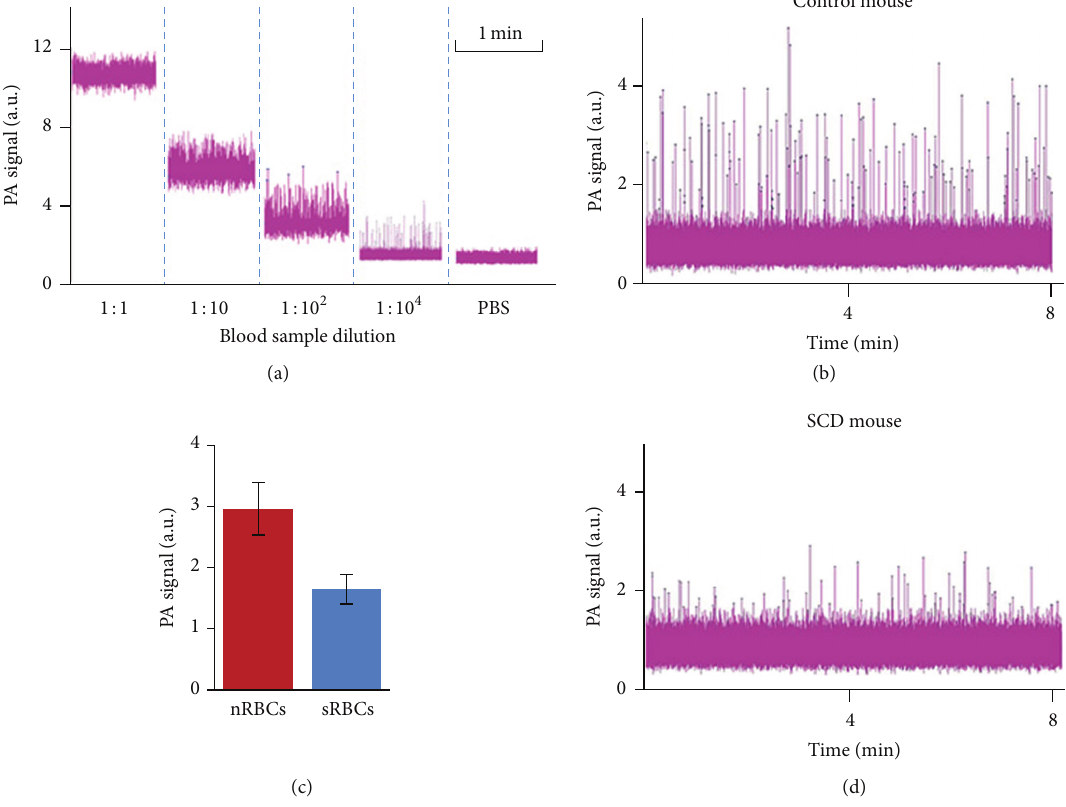
Figure 6: In vitro PAFC of sRBCs. (a) PA signal amplitudes from nRBCs of SCD mouse, flowing in a capillary tube at different dilutions showing completely overlapped (1: 1) and nonoverlapped (1:10 4 ) signal peaks from individual sRBCs. (b, d) Typical PA signal traces with nonoverlapping peaks from individual nRBCs of a nude mouse (b) and sRBCs of a SCD mouse (d). (c) Averaged PA signal amplitudes from nRBCs and sRBCs in (b,